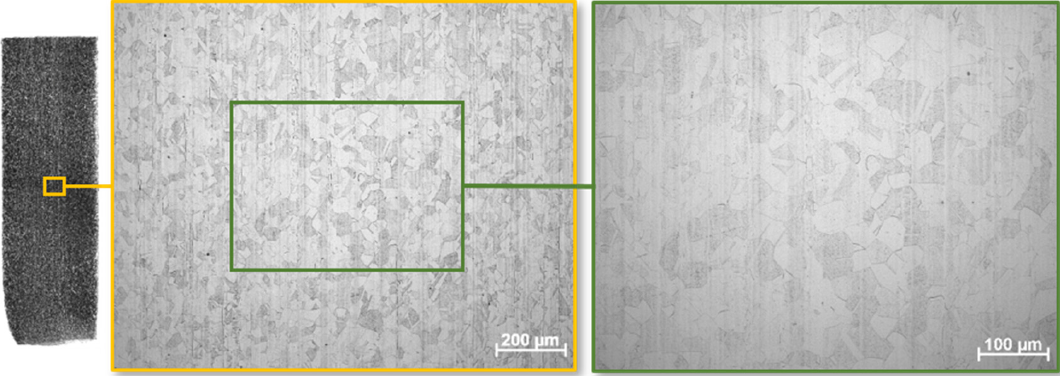
Figure 5. Microstructure of a sheet metal (reference material).